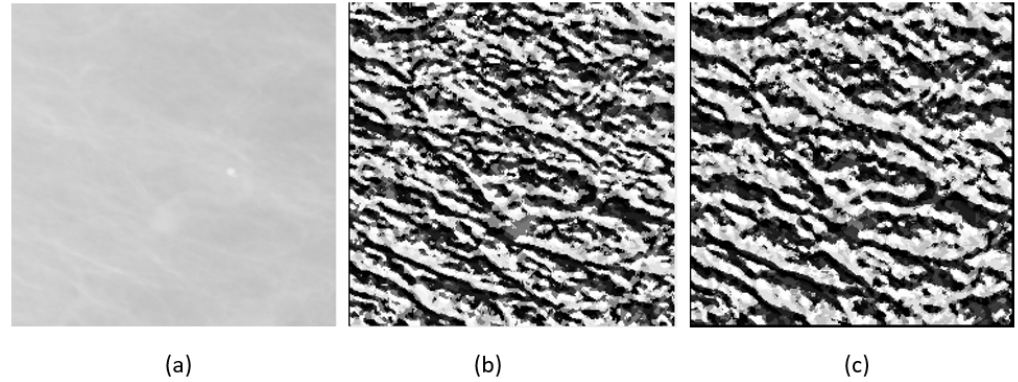
Figure 4. Effect of horizontal and vertical M-ELBP on mammographic RoI ( a ) Original Image ( b ) M-ELBP pattern for M - ELBP 8,7,4 at θ = 0 ◦ ( c ) M - ELBP pattern for M - ELBP 8,4,7 θ = 90 ◦